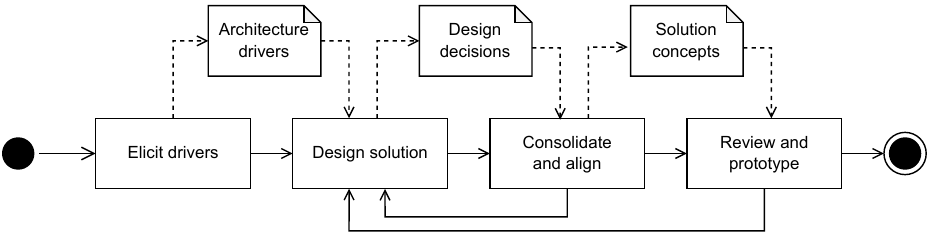
Figure 2. Activities performed as part of the research